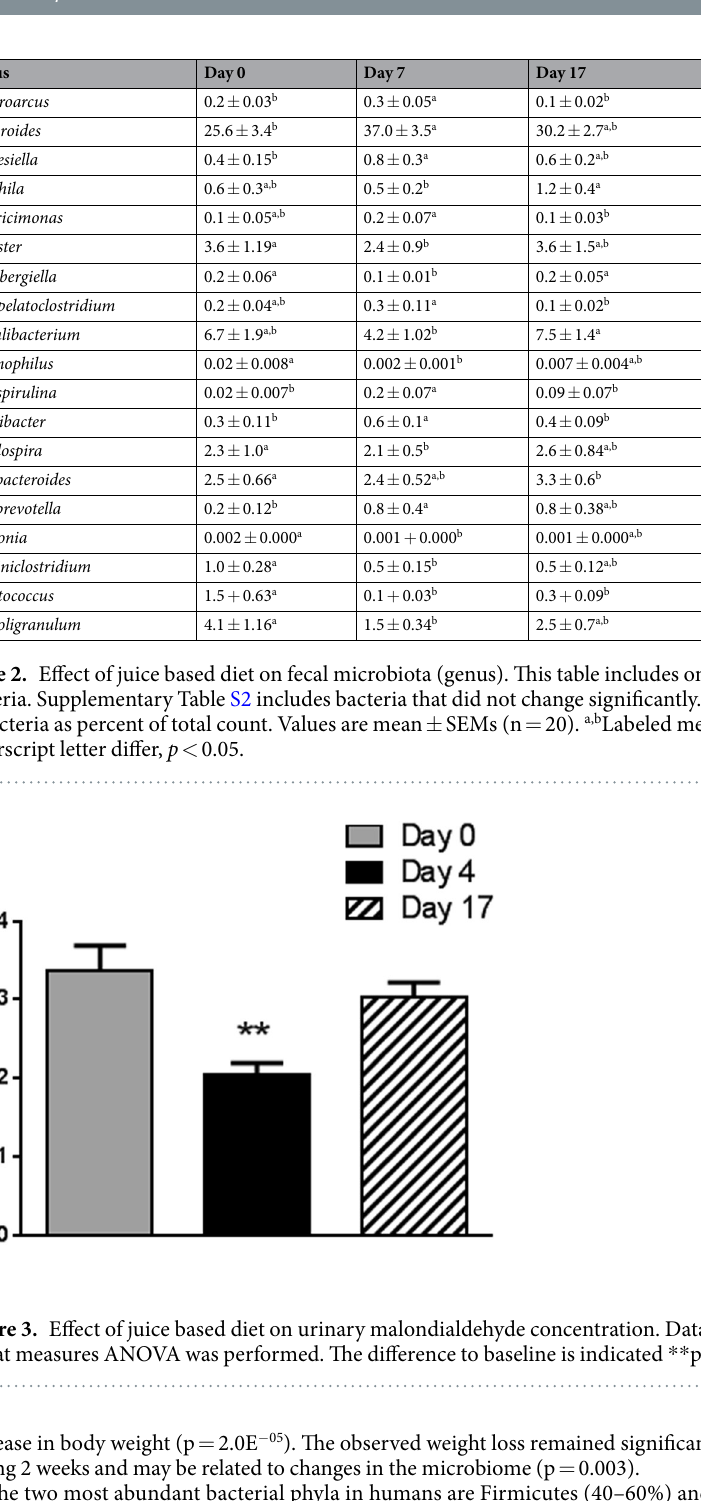
4 Scientific RepoRts | 7: 2167 | DOI:10.1038/s41598-017-02200-6